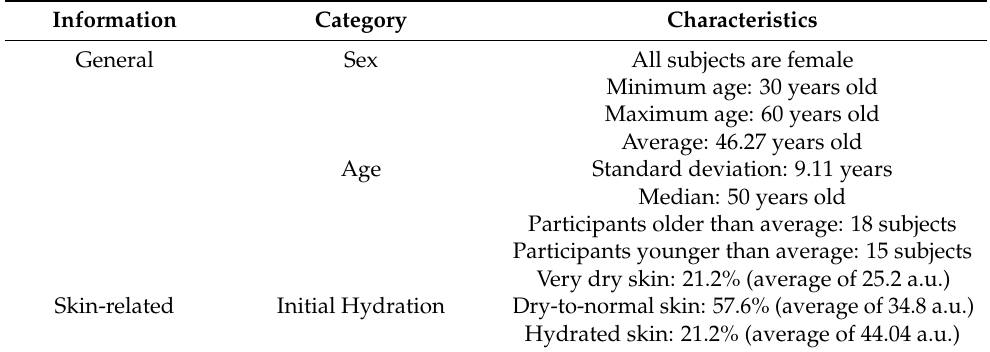
Table 3. Characterization of subjects’